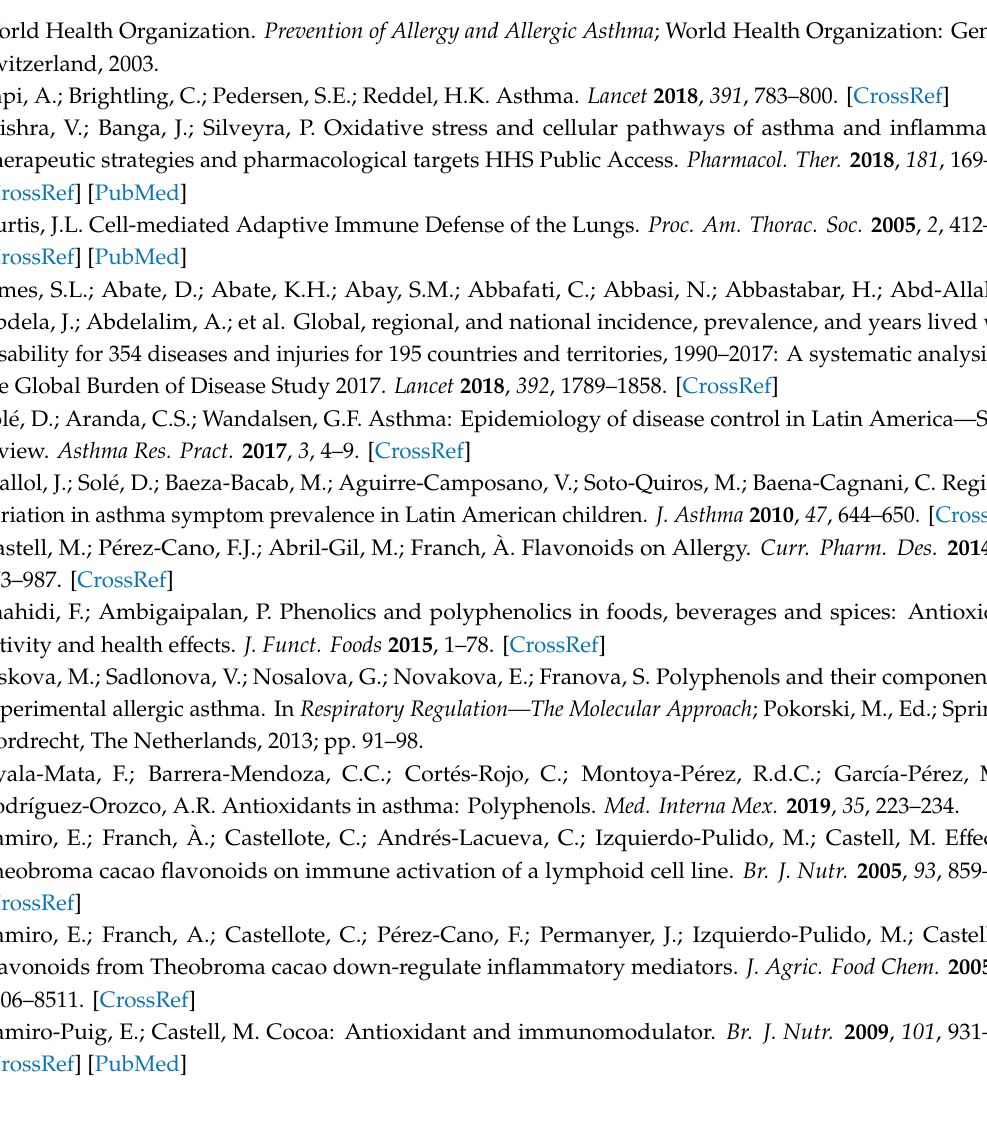
Table S1: Food intake for all experimental groups throughout the study. Table S2: Water consumption for all experimental groups throughout the